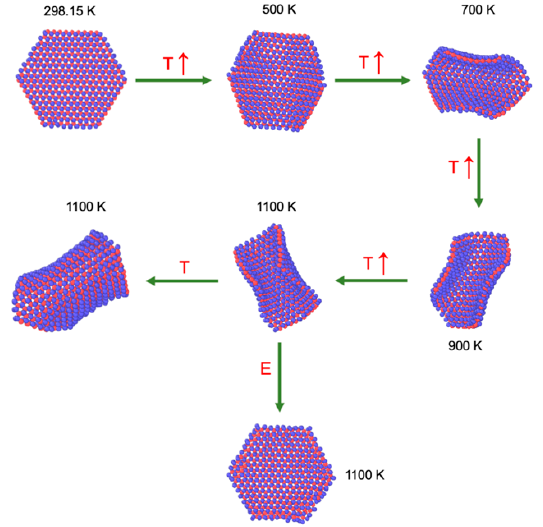
Figure 3. Snapshots of the 1L Mo 243 S 486 flake under vacuum. From 298.15 to 1100 K, the T of the flake was increased at a rate of 100 K/300 ps. At 1100 K, the flake was maintained at constant T (NVT) for several ns. In a parallel simulation, the flake was also simulated under NVE conditions for several ns. Blue and red spheres represent Mo and S atoms, respectively.